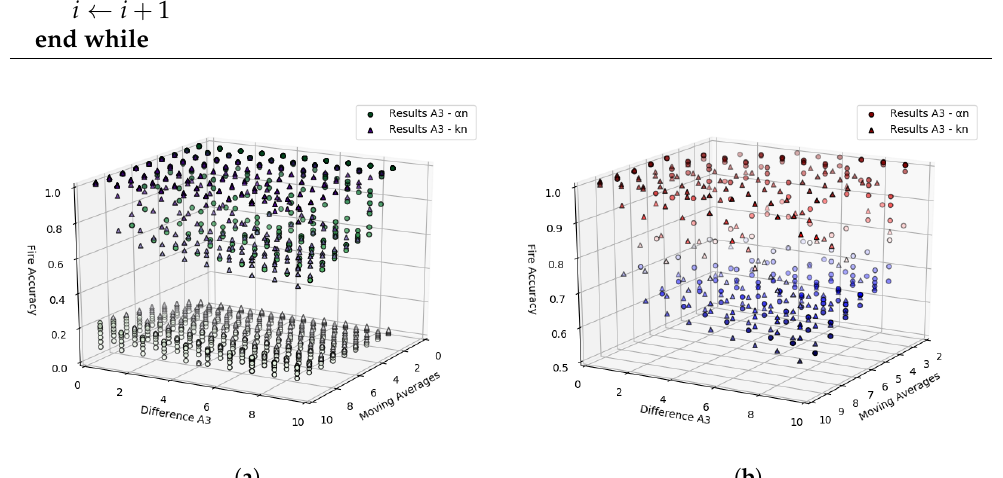
Figure 14. Graph visually demonstrating the result of the A 3 approach with the range from 0 to